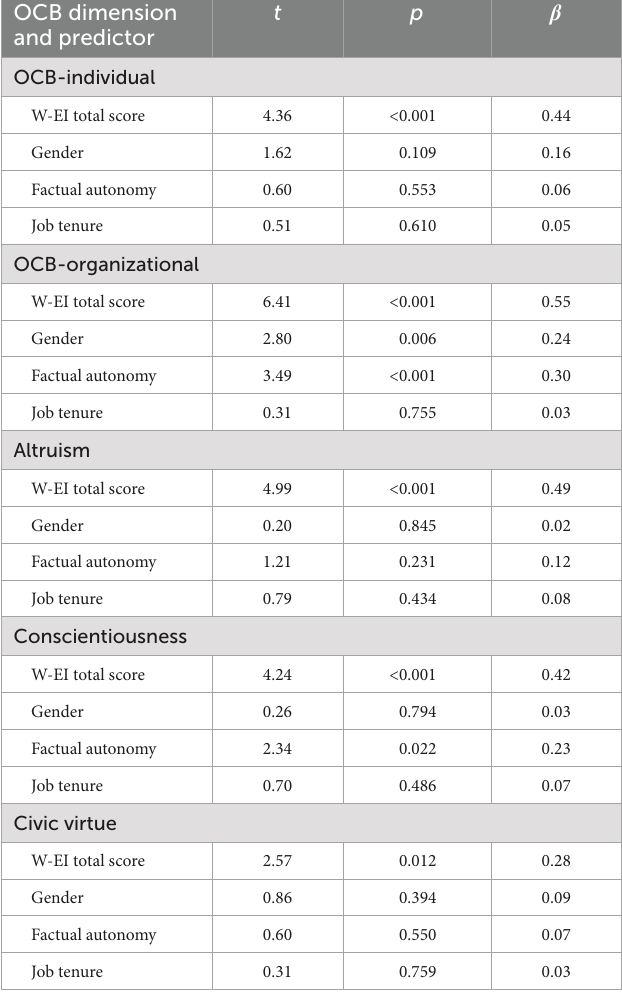
TABLE 2 Work-related emotional intelligence (W-EI) as a predictor of organizational citizenship behavior (OCB), multiple regression results, Study 1.